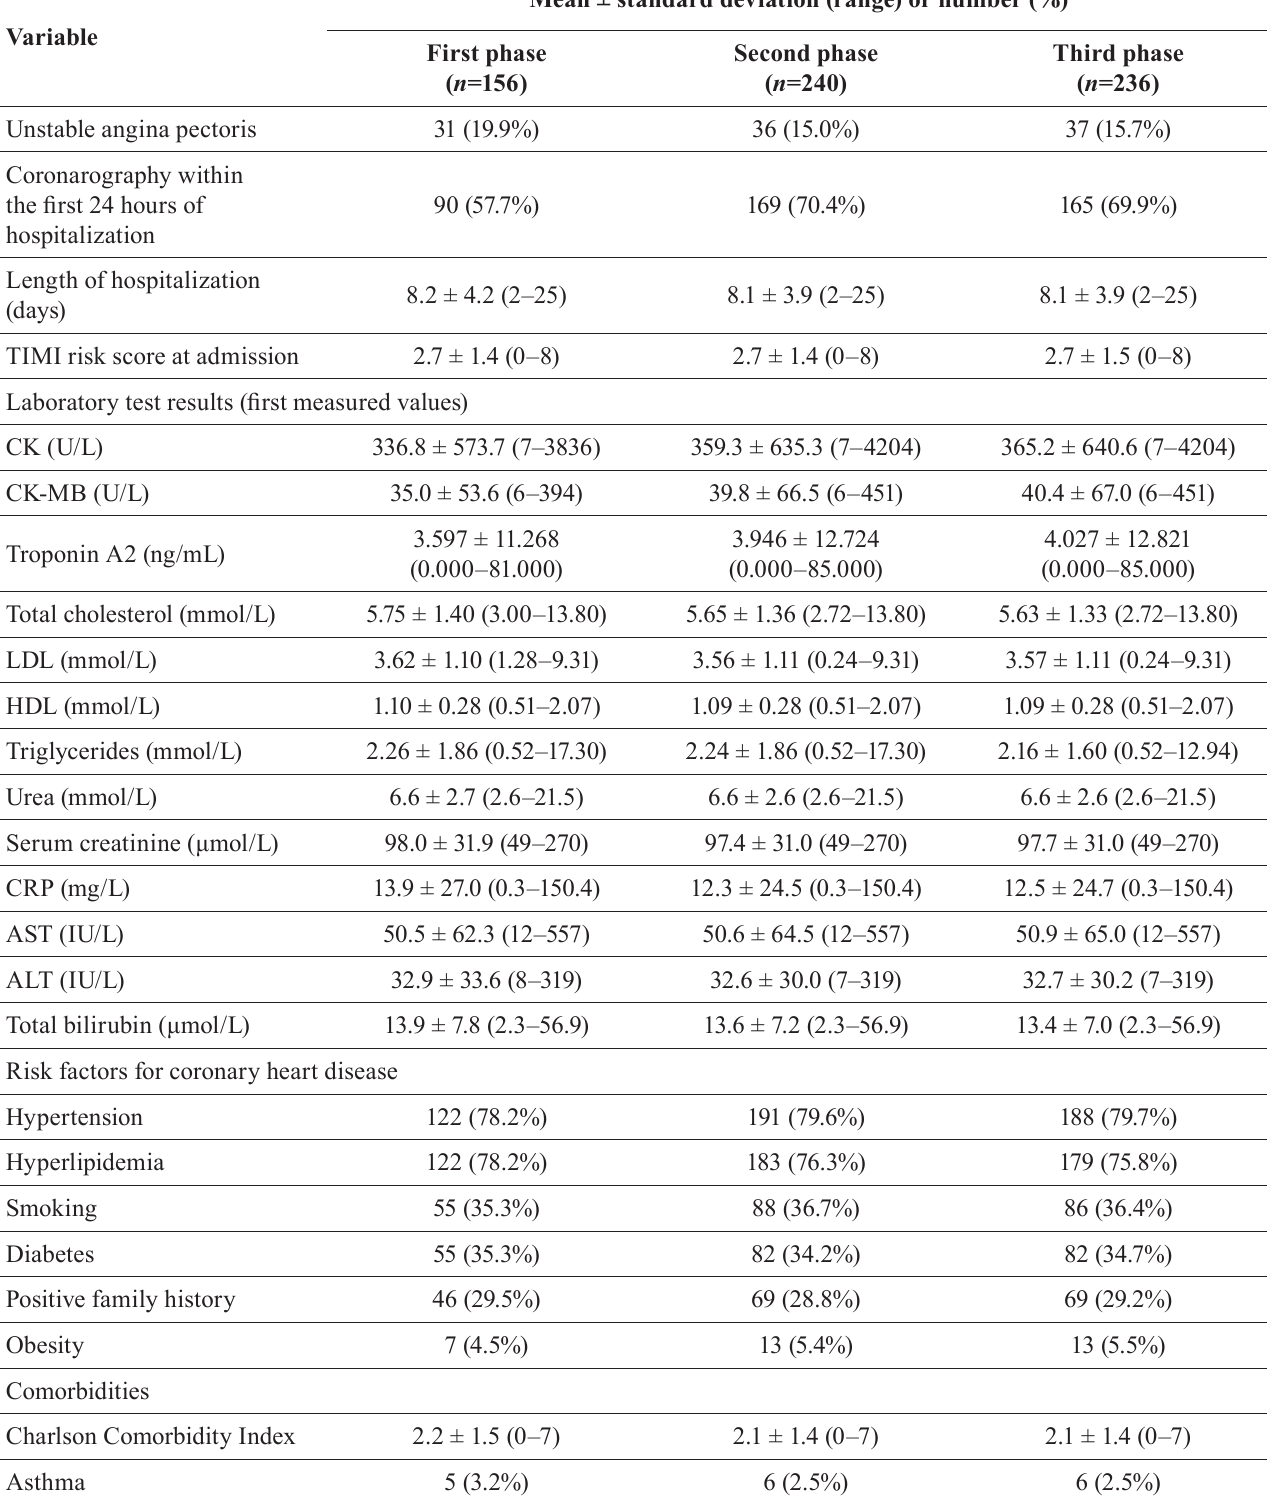
TABLE I - C haracteristics of the study population of acute coronary syndrome patients receiving statin therapy